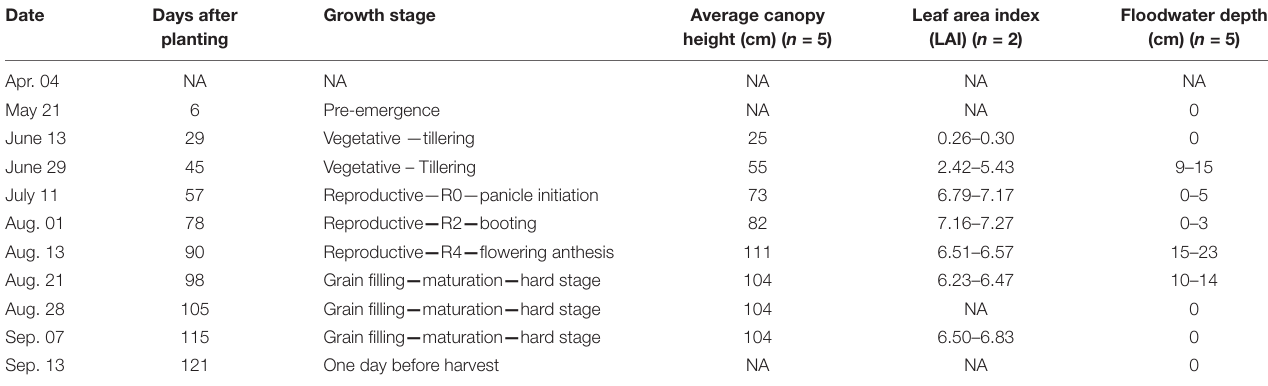
TABLE 2 | Flyover dates for the 2019